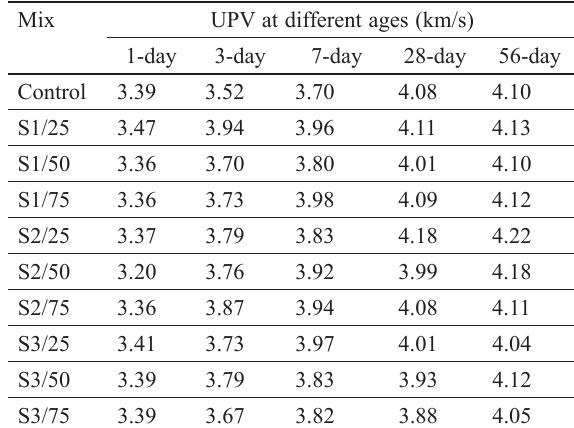
Table 6. Ultrasonic pulse velocity (UPV) of